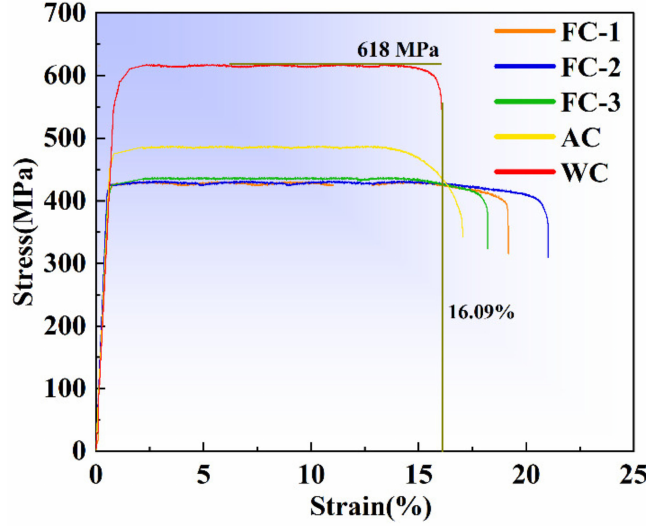
Figure 10. Engineering stress-strain curves of Zr-4Hf-3Nb (wt%) alloy. With various cooling rate.